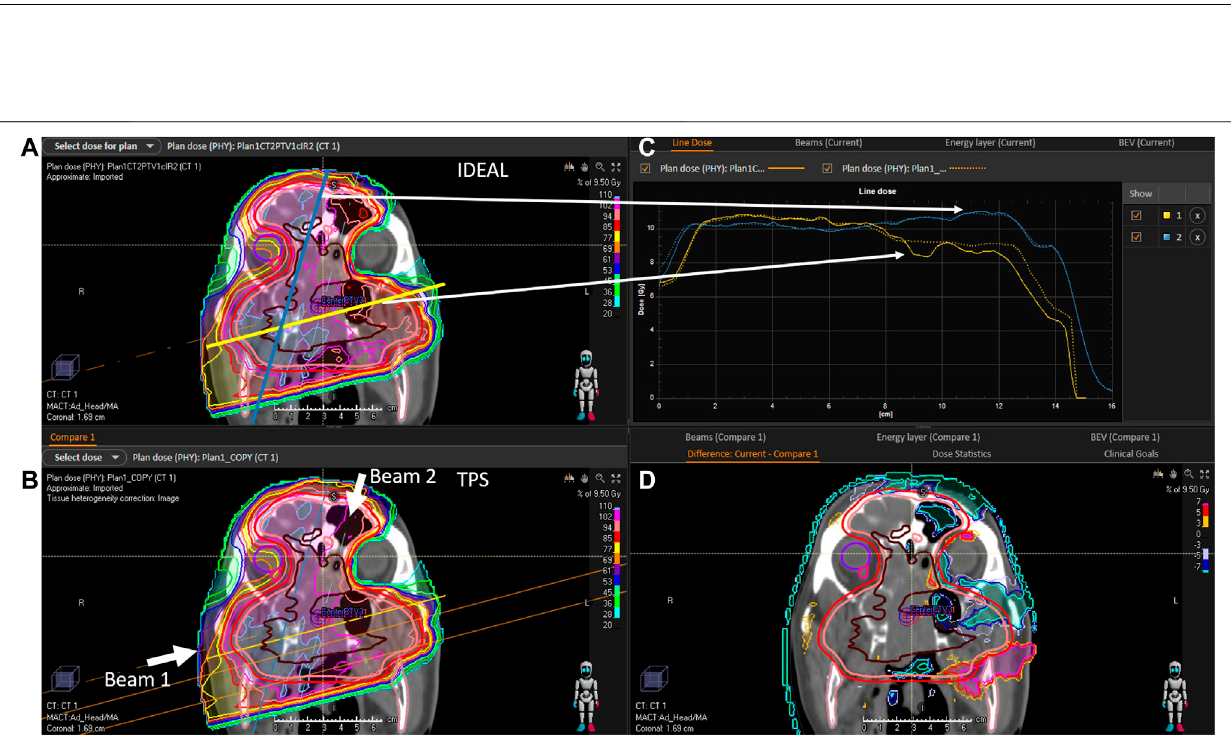
Frontiers in Physics |